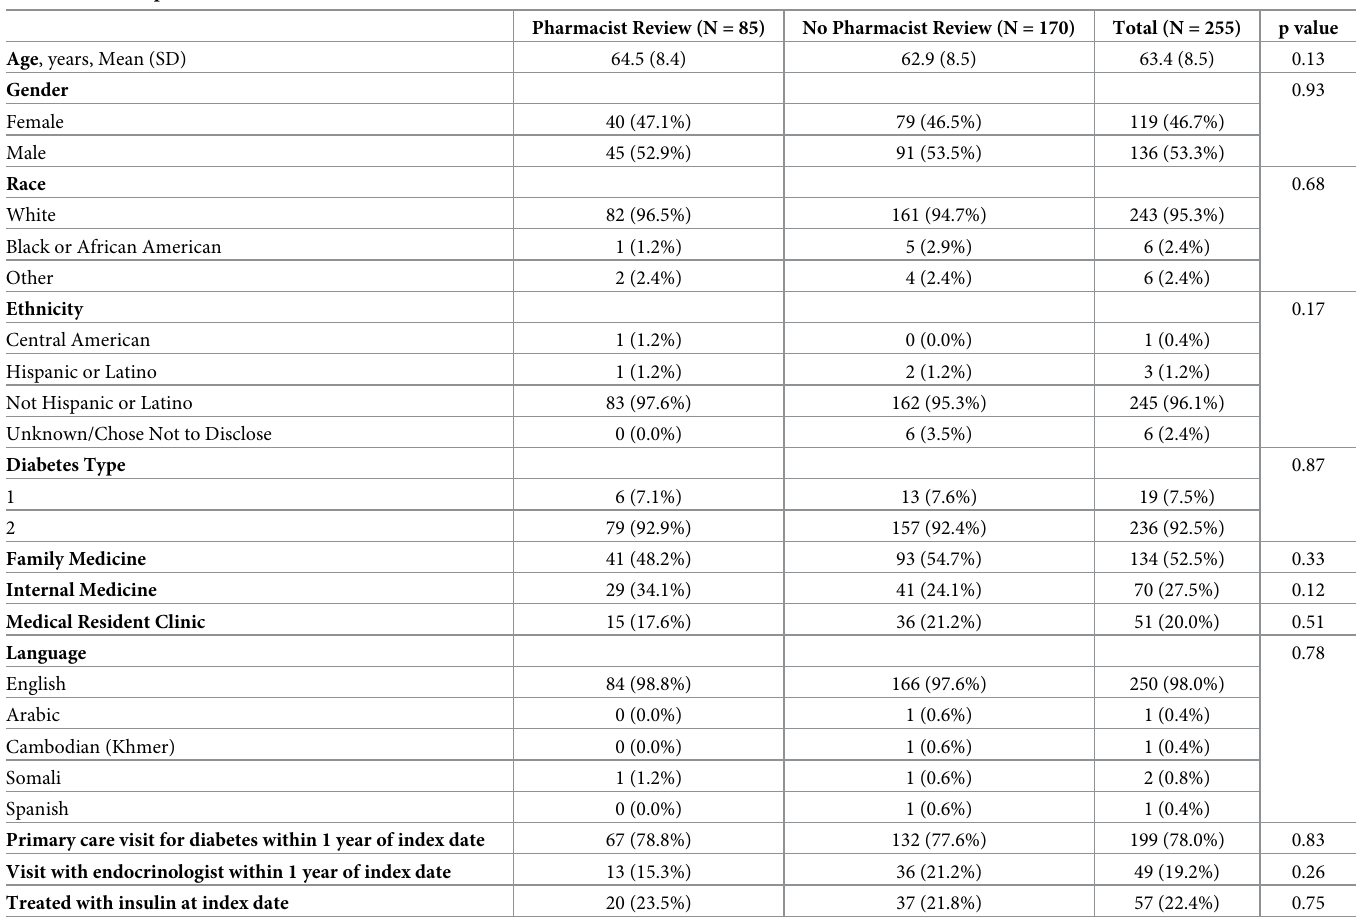
Table 1. Baseline patient